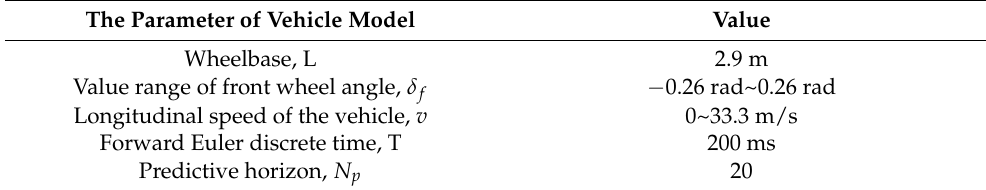
Table 1. Basic parameters of vehicle